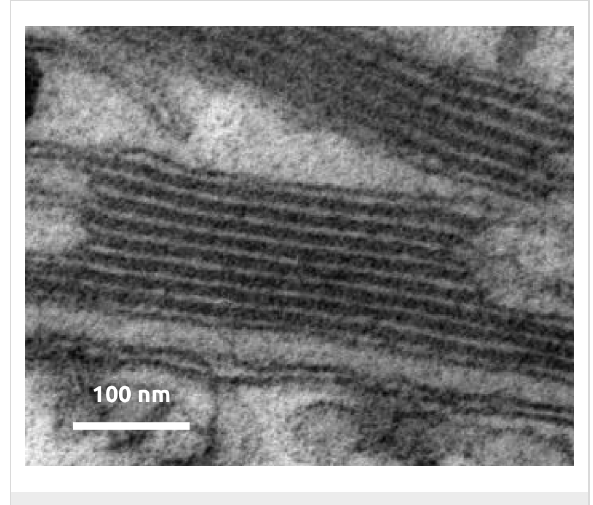
Figure 2: An example of nanostructured interfaces in an energy conversion device: thylakoids for photosynthesis (micrograph adapted and reproduced with author permission; (c) Andreas Anderluh and Bela